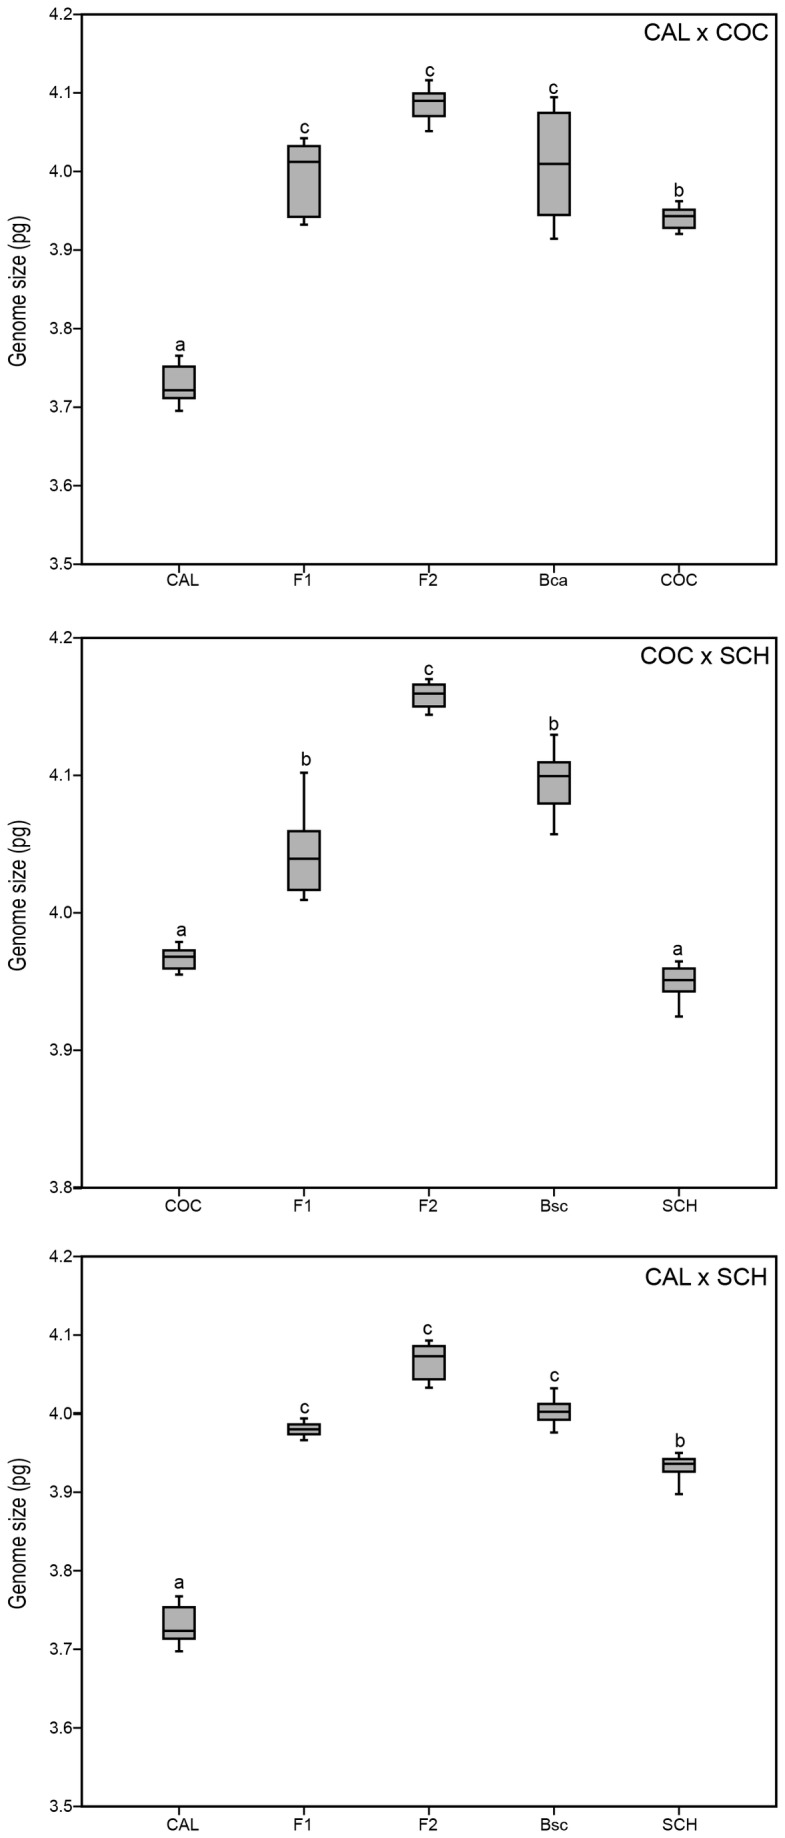
Genome size obtained of the three pairs of hybridizing species of Epidendrum: E. calanthum x E. cochlidium; (A); E. cochlidium x E. schistochilum (B); E. calanthum x E. schistochilum (C).CAL = E. calanthum; COC = E. cochlidium; SCH = E. schistochilum according with genetic groups detected previously by NEWHYBRIDS. Values are expressed in pg (N = 158 plants).